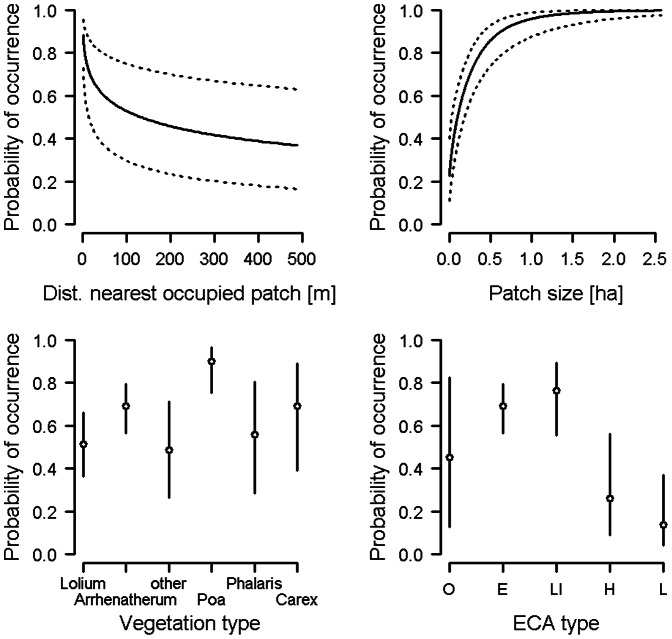
Patch occupancy in the field cricket.Probability of occurrence of the field cricket in a patch in relation to distance to the nearest occupied patch, patch size, vegetation type and ECA type (E  =  extensively managed meadow, LI  =  meadow used at low intensity, H  =  hedgerow with herbaceous strip, L  =  litter meadow, O  =  others). Plots show predicted values (solid lines and open circles) and 95% CI (dashed lines and vertical bars) from the model. Noccupied  = 173, nunoccupied  = 179.